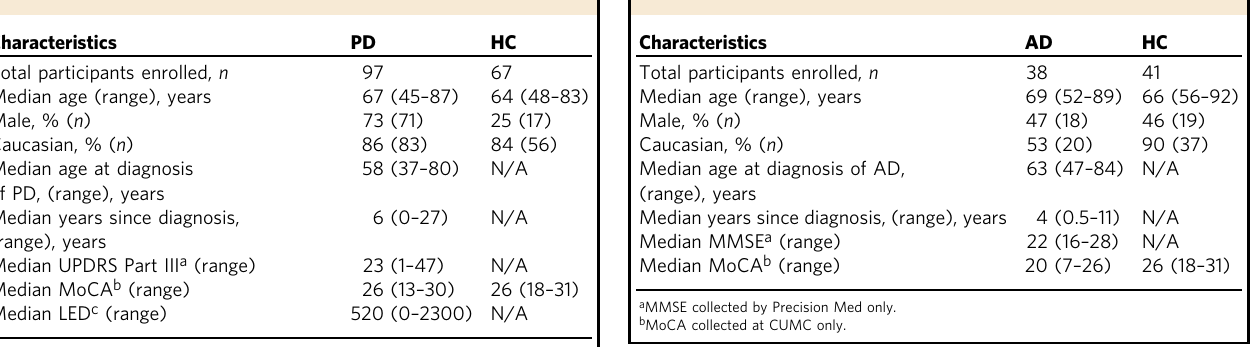
Table 2 Demographic characteristics of enrolled PD and Table 3 Demographic characteristics of enrolled AD